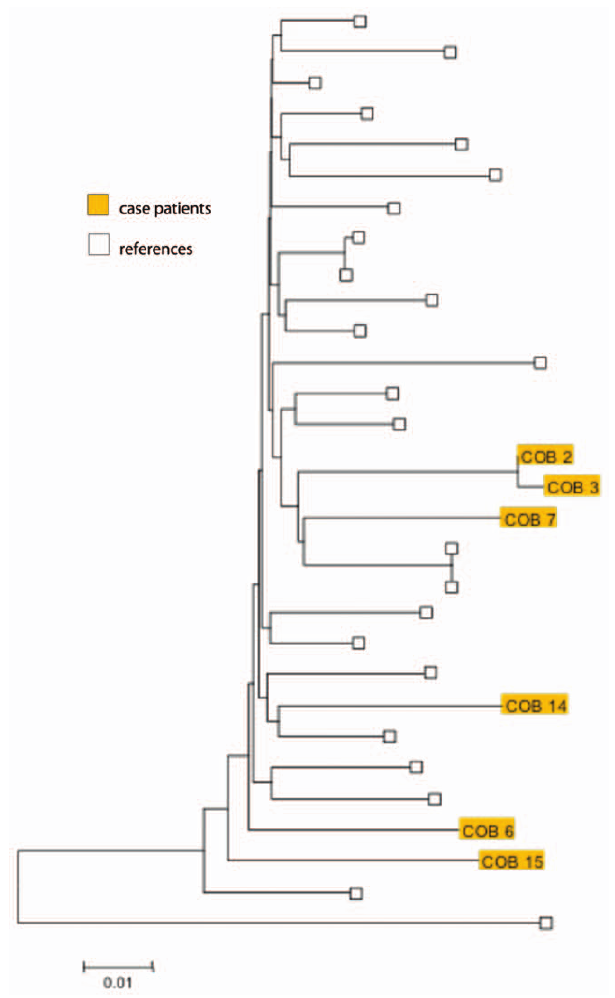
Figure 2. Phylogenetic relationship of the HIV sequences of 6 LTCF A residents with HIV infection (4 newly diagnosed), 23 reference US subtype B sequences, and one reference subtype C sequence (the outgroup). The 6 LTCF A residents are shown by the solid boxes. The tree was derived from a nucleotide alignment of the 1497-bp pro-pol region. Trees were inferred from 3 different phylogenetic analysis methods (neighbor-joining, maximum likelihood, and Bayesian inference) which independently showed that 2 sequences (COB 2 and COB 3) consistently cluster together with high bootstrap/ statistical support (99/100/1.0 respectively). These two sequences show a pairwise nucleotide identity of 99.3%.